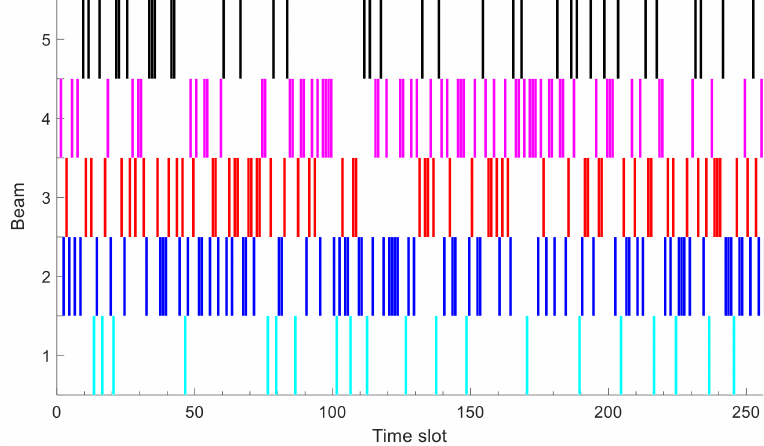
Figure 7. Beam hopping time slots allocation